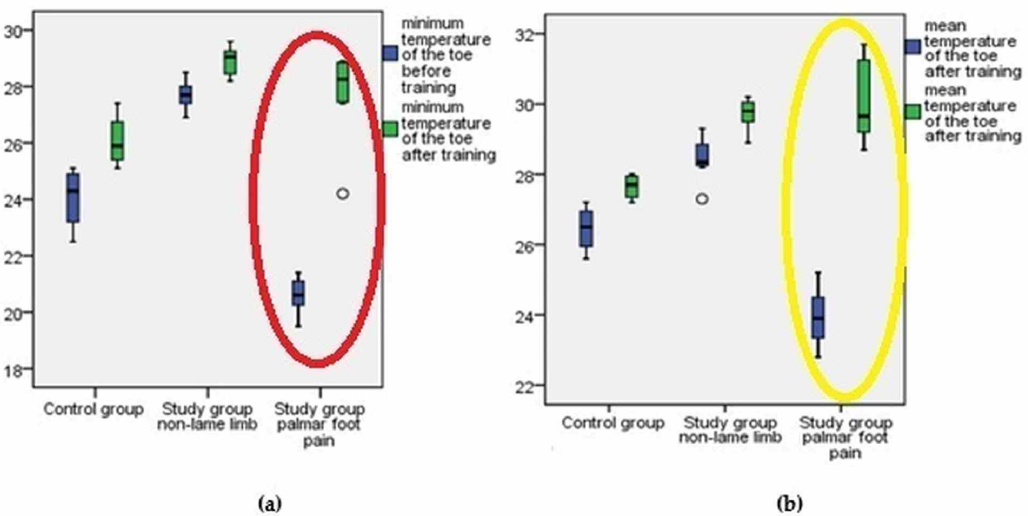
Figure 7. ( a ) Boxplot diagram showing the minimum temperature values of the toe area before and after training. An obvious difference is observed for the minimum temperature of the toe area before (blue mark) and after training (green mark) for the study group with palmar foot pain (red circle). ( b ) Boxplot diagram showing the mean temperature values of the toe area before and after training. Low values for mean temperature of the toe area are observed before (blue mark) and after training (green mark) for the study group with palmar foot pain (yellow circle); °—mild outliers temperature.